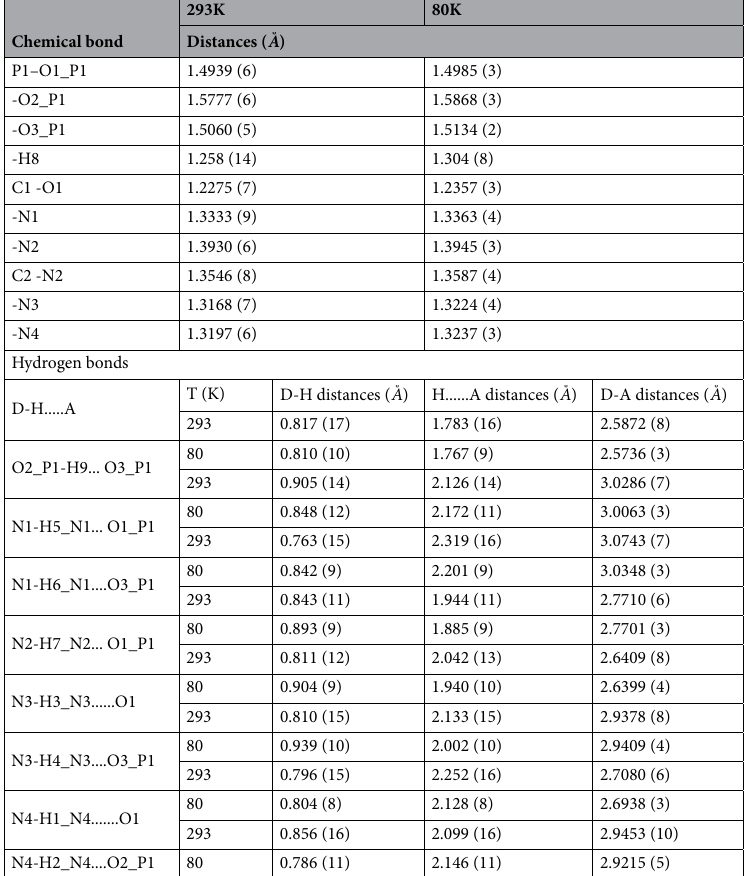
Table 2. Interatomic distances in the structures of ( NH 2 ) 2 CNHCO ( NH 2 ) H 2 PO 3 single crystal at 293K and 80K.